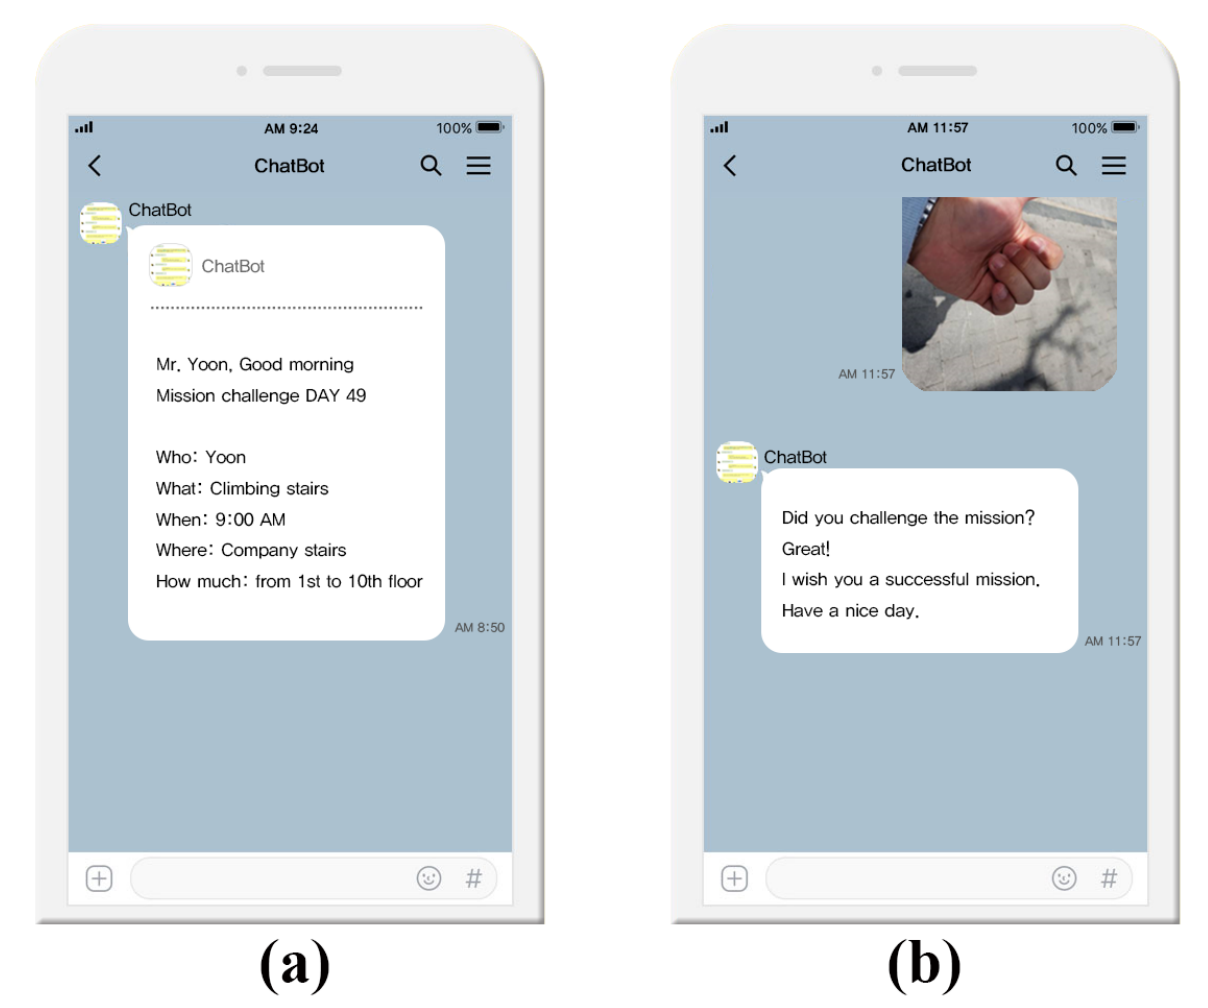
Figure 2. Screenshots of (a) push alarm reminders and (b) uploaded picture evidence and accomplishment with positive reinforcement as an intrinsic